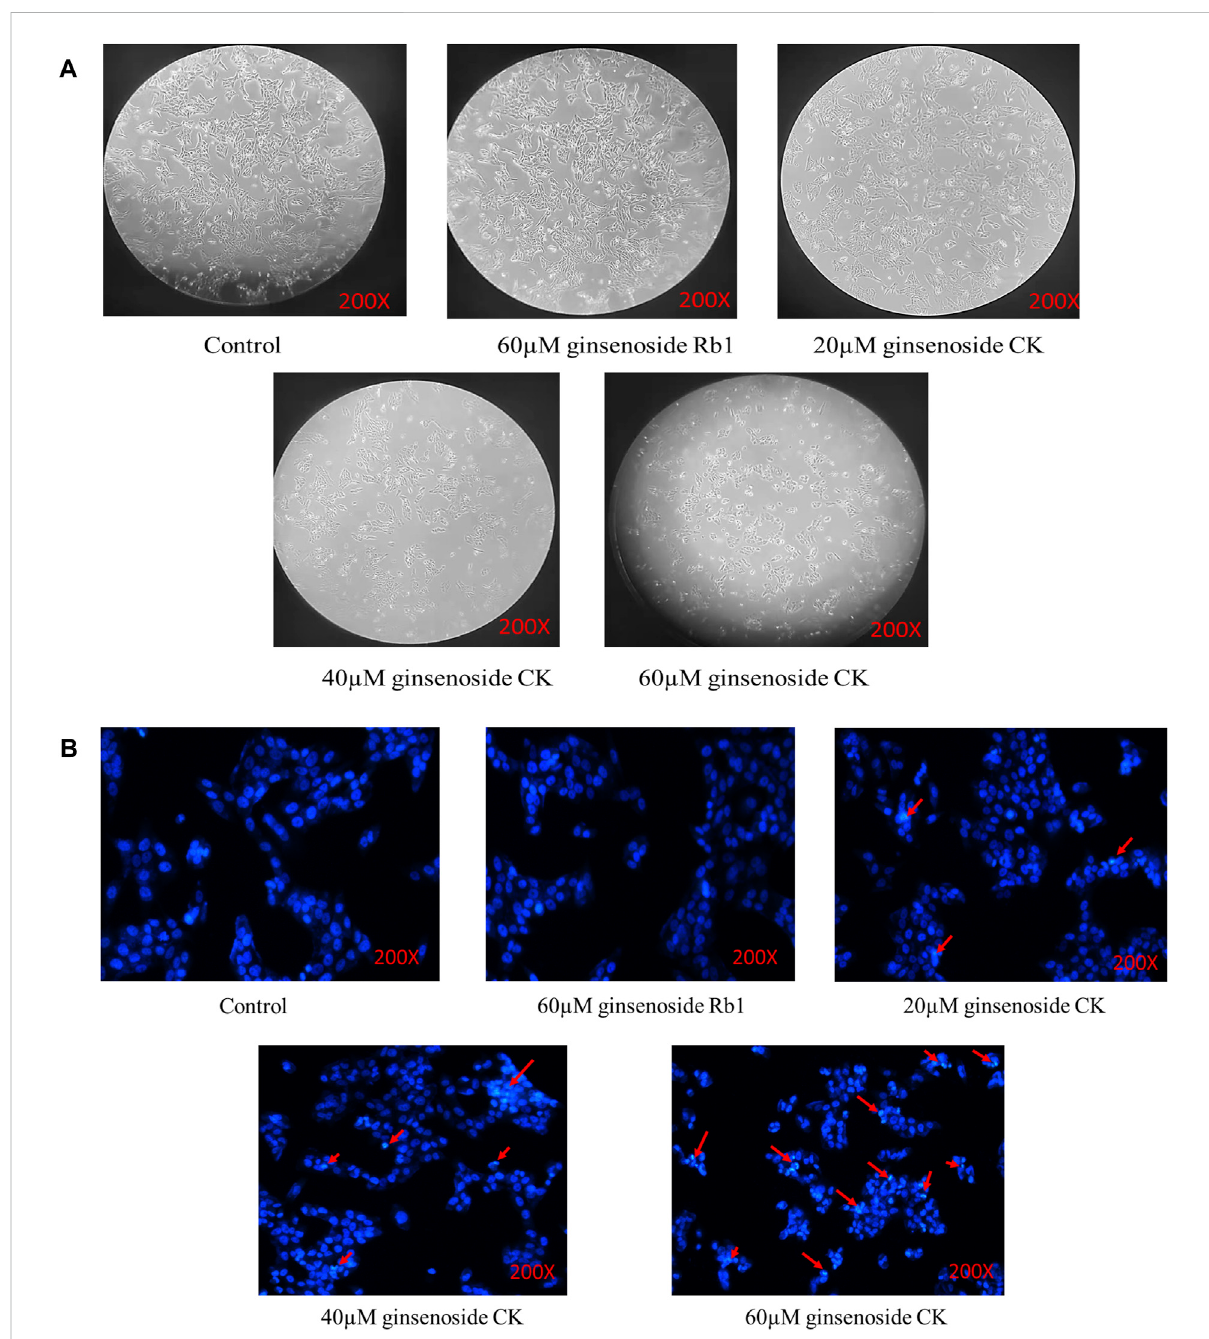
FIGURE 3 Effects of ginsenoside Rb1 and CK on the morphology and apoptosis of HGC-27 cells (A) Changes of cell morphology in each group after drug treatment. (B) Hoechst33258 staining results.